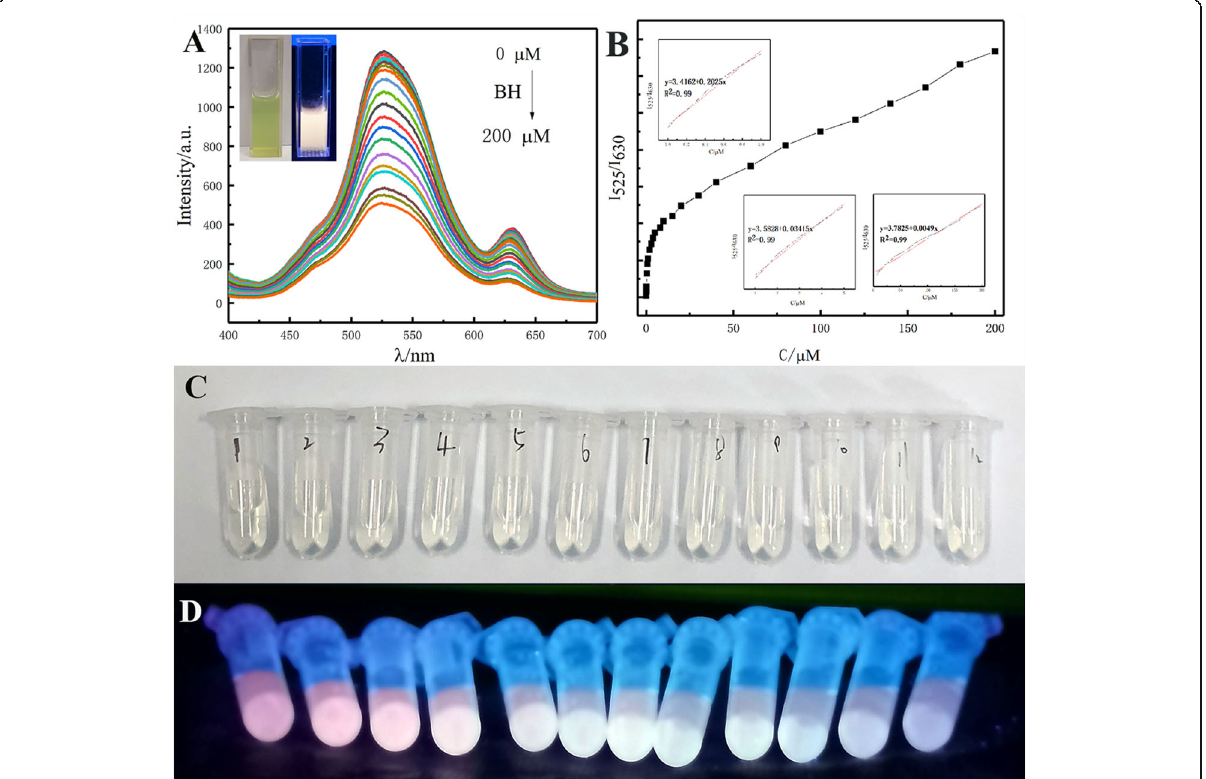
Fig. 3 a Fluorescence emission spectra of ratiometric fluorescent probe respond to different concentrations of BH (from 0 to 200 μ M) (insets showed the fluorescence color change under a 365-nm UV lamp in the presence of 50 μ M BH (right) and blank (left)), b fluorescence intensity of ratiometric fluorescent probe changed in the range of 0 – 200 μ M BH (insert: linear relationship between the fluorescent ratio of I 525 /I 630 and the BH concentrations). The color change of the sensing sensor responds to different BH concentrations (0, 0.001, 0.005, 0.01, 0.05, 0.1, 0.5, 1, 2, 3, 4, 5 μ M) c under daylight and d a 365-nm UV